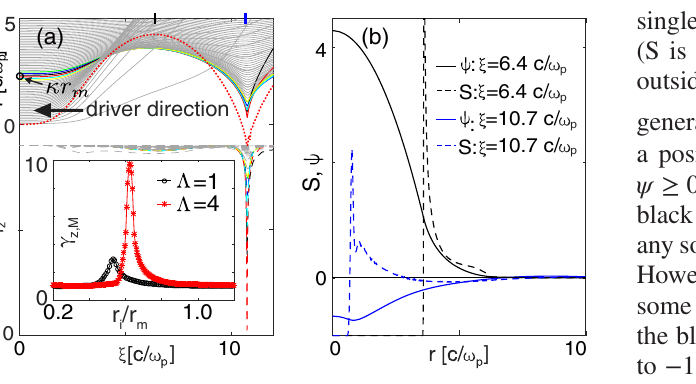
FIG. 2. (a) The trajectories (solid lines) and the − γ z (dashed lines) of the electrons in a uniform plasma with n p ¼ 1 . 5 n p 0 and ω p is the corresponding plasma frequency. The red dotted line is the on-axis ψ 0 . The inset shows the dependence of γ z;M of the electrons on the initial radius under different drivers. The black and blue markers correspond to ξ ¼ 6 . 4 c= ω p and 10 . 7 c= ω p . (b) The source term S and pseudo-potential ψ at different ξ . The blue dashed line is an average. The parameters of the beam drivers are the same as the Λ ¼ 4 case in Fig.